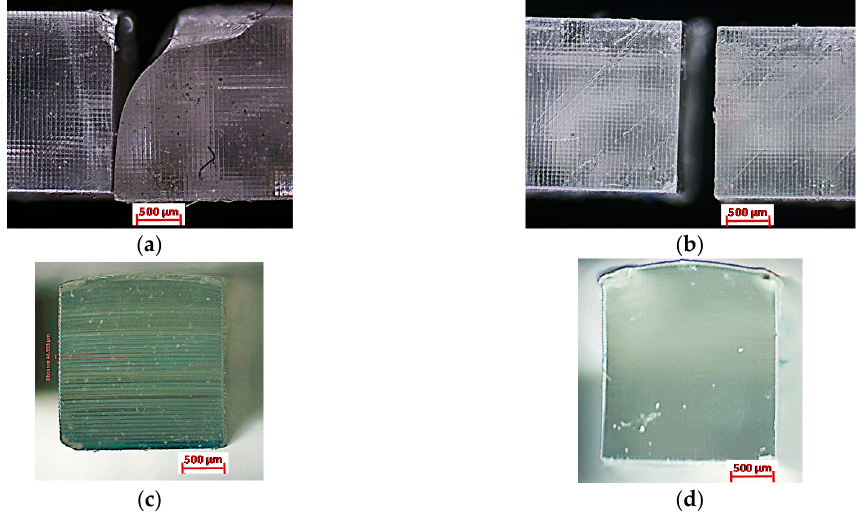
Figure 11. Brittle failure of the UTS specimen from the top view for ( a ) 50 µm and ( b ) 10 µm layer thickness, from the section view for ( c ) 50 µm and ( d ) 10 µm layer thickness.